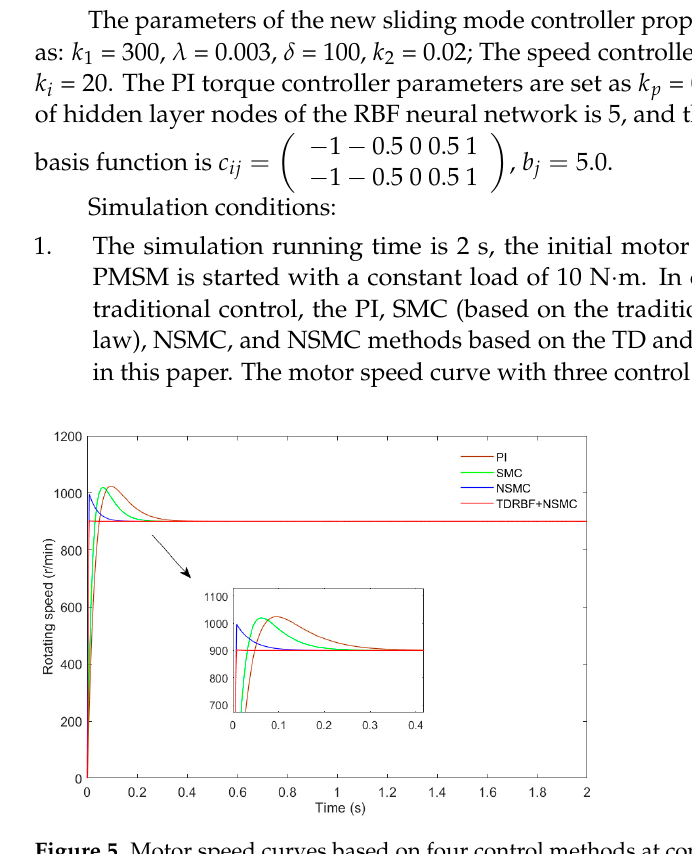
Figure 5. Motor speed curves based on four control methods at constant load.